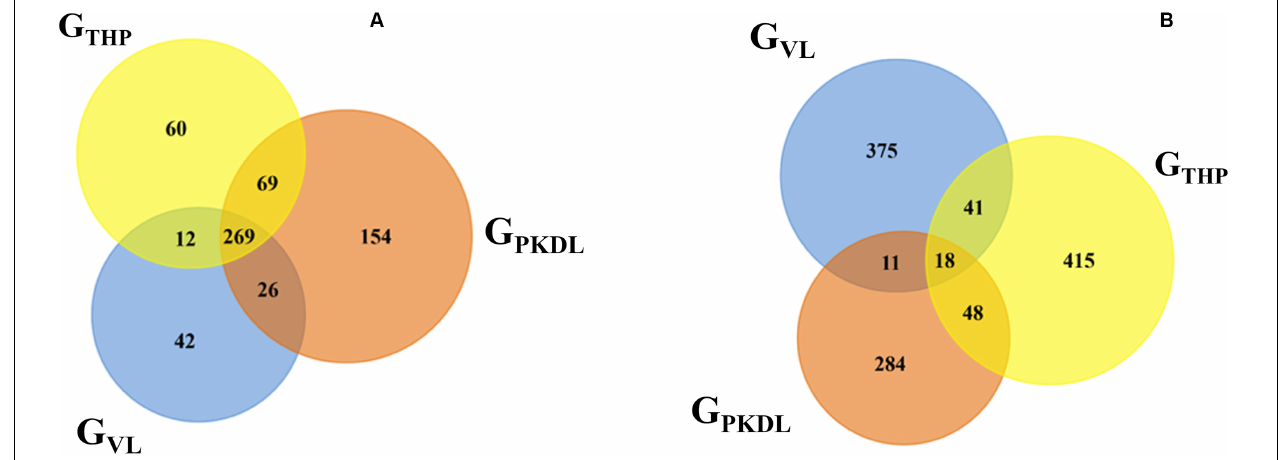
FIGURE 3 | Venn diagram showing the differentially expressed overlaps of microRNA (miRNA). (A) Overlaps of known miRNAs between G THP (THP-1), G VL [visceral leishmaniasis (VL)], and G PKDL [post-kala-azar dermal leishmaniasis (PKDL)] groups. (B) Overlaps of novel miRNAs between G THP , G VL , and with G PKDL groups.